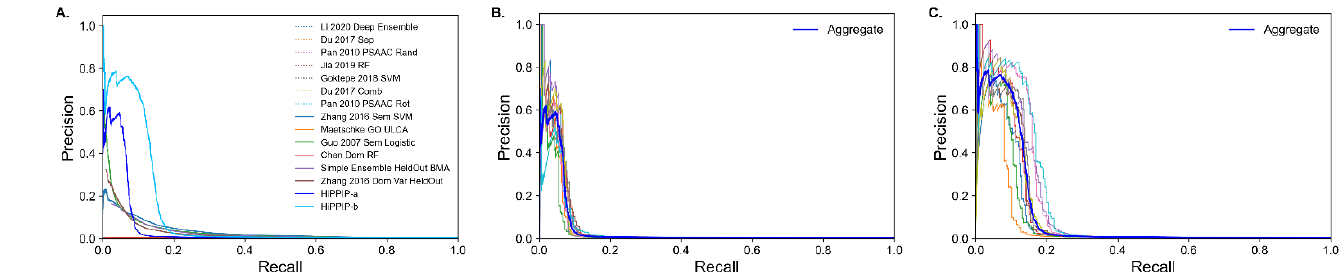
Figure 4. Evaluation of HiPPIP. ( A ) Comparison of HiPPIP with selected sequence-based and annotation-based methods that performed the best. The two lines HiPPIP-a and HiPPIP-b correspond to whether the known PPIs in the test data were drawn from recent version of BioGRID (May 2021, same as used in this paper) or from an earlier version of BioGRID (January 2017). Both lines in ( A ) show an average performance across 10 datasets, whereas performance on individual datasets in each set are shown in ( B ) and ( C ), respectively. For all methods, including sequence-based and annotation-based methods, pairs that appear in the HPRD database are also treated as true-positives in this figure; there is no discernable difference between the results of the sequence-based and annotation-based algorithms in Figure 3C and here, despite the inclusion of HPRD PPIs as positive labels. It is estimated that HiPPIP-a and HiPPIP-b test datasets may have about 24% and 14% overlap for positive instances respectively, because the specific pairs used in training HiPPIP are